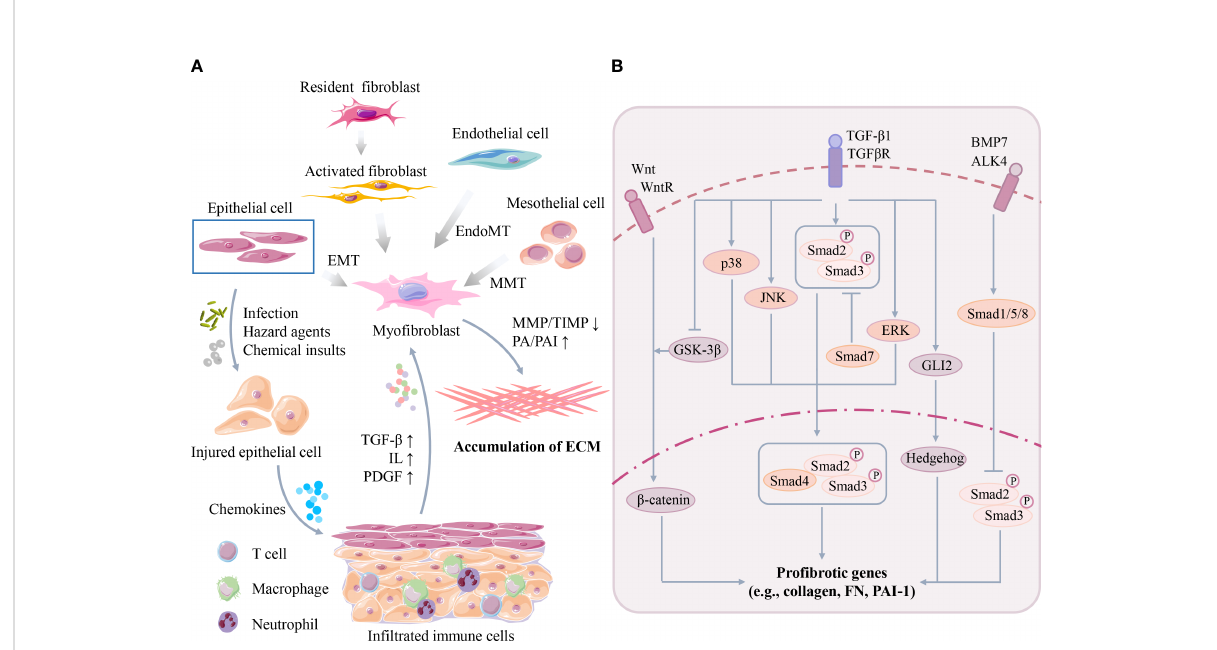
FIGURE 2 (A) Key cellular events of organ fi brosis. Organ damage can trigger in fi ltration of immune cells, followed by secretion of excessive cytokines/ chemokines to activate myo fi broblasts. Myo fi broblasts are originated from many cell types, such as epithelial cells, mesothelial cells and endothelial cells, through EMT, MMT or EndoMT. Activated myo fi broblasts promote organ ECM synthesis/deposition. (B) Key signaling pathway of organ fi brosis. TGF- b participates in the molecular mechanism of fi brosis in Smad-dependent and Smad-independent manner such as MAPK families. Moreover, TGF- b also interacts with other pro fi brotic pathways, such as the Wnt/ b -catenin, Hedgehog and BMP-7 pathways. (TGF- b , transforming growth factor- b ; ILs, interleukins; PDGF, platelet-derived growth factor; EMT, epithelial to mesenchymal transition; MMT, mesothelial to mesenchymal transition; EndoMT, endothelial to mesenchymal transition; MMP, matrix metalloproteinase; TIMPs, tissue inhibitors of matrix metalloproteinases; PA, plasminogen activator; PAI, plasminogen activator-inhibitor 1; MAPK, mitogen-activated protein kinase; JNK, JUN amino-terminal kinase; ERK, extracellular signal-regulated kinase; GSK-3 b , glycogen synthase kinase-3 b ; FN, fi